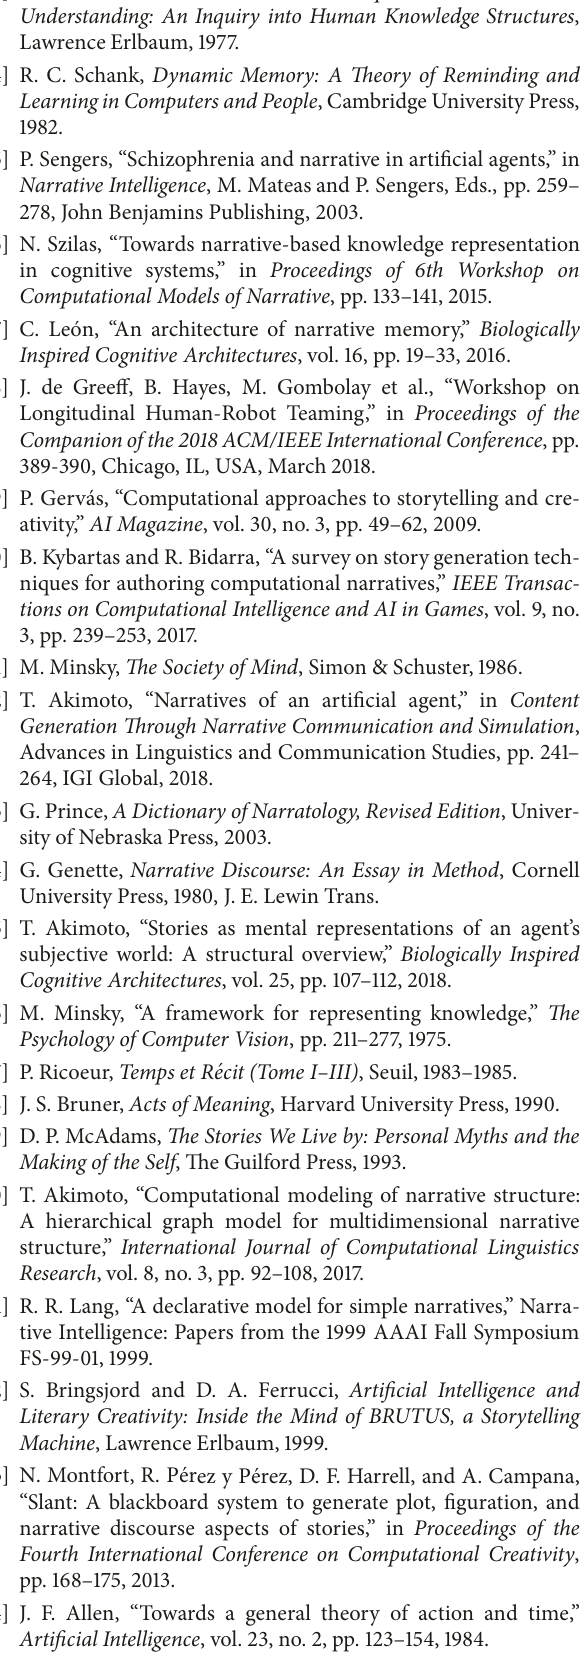
“Slant: A blackboard system to generate plot, figuration,